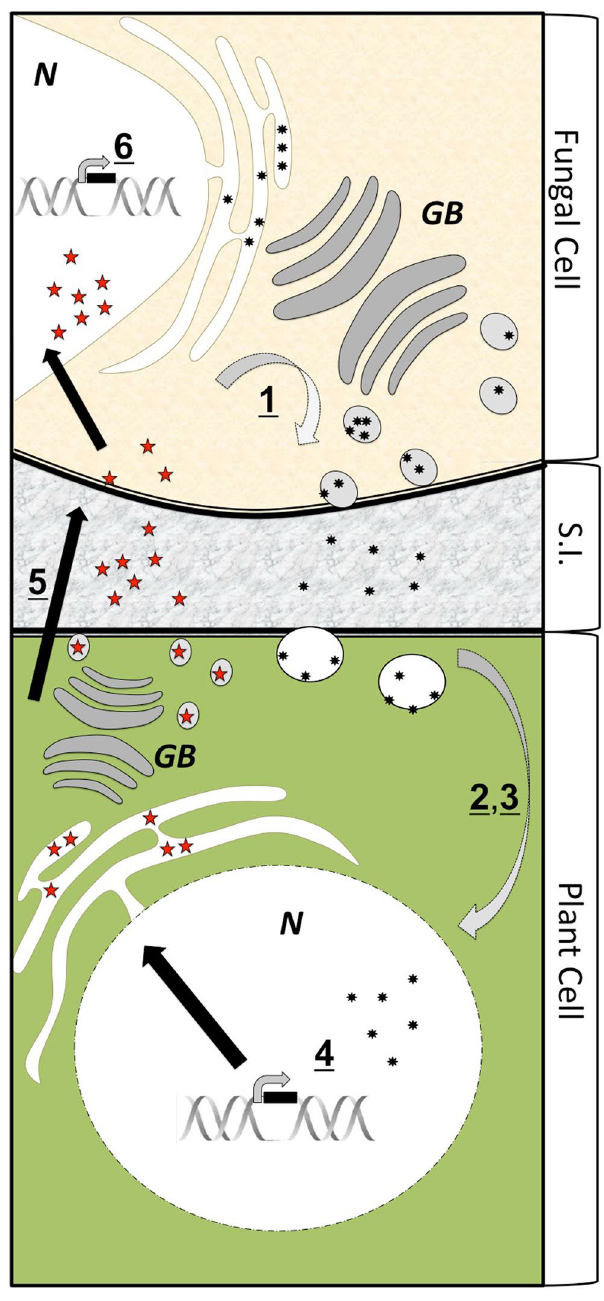
Figure 7. Proposed model of reciprocal small secreted proteins (SSP) feedback between ectomycorrhizal fungi and their host plants. During colonization of receptive plant hosts, fungal hyphae (brown cell) produce effector-like SSPs (black stars) that are secreted from the hyphal cell (#1). A portion of these proteins cross the symbiotic interface (grey shaded area) and enter the plant cell (green cell; #2) where they localize to different sub-cellular compartments (#3). These effectors may induce a change in the transcription of host genes (#4; adapted from Plett et al. 35 ). Plant cells, in turn, produce small effector-like SSPs (red stars) that are secreted, cross the symbiotic interface (#5) where some may enter the hyphal cell and localize to different sub-cellular compartments. Some effectors may induce a change in the transcription of host genes (#6). GB = Golgi bodies; N = nucleus; S.I. = symbiotic interface. Note: we do not currently know the priority of this signaling network (i.e. if the fungus signals and the plant responds or vice-versa). Rather, numbering here is used to enable description of the different steps in a feedback system that is likely reciprocal in